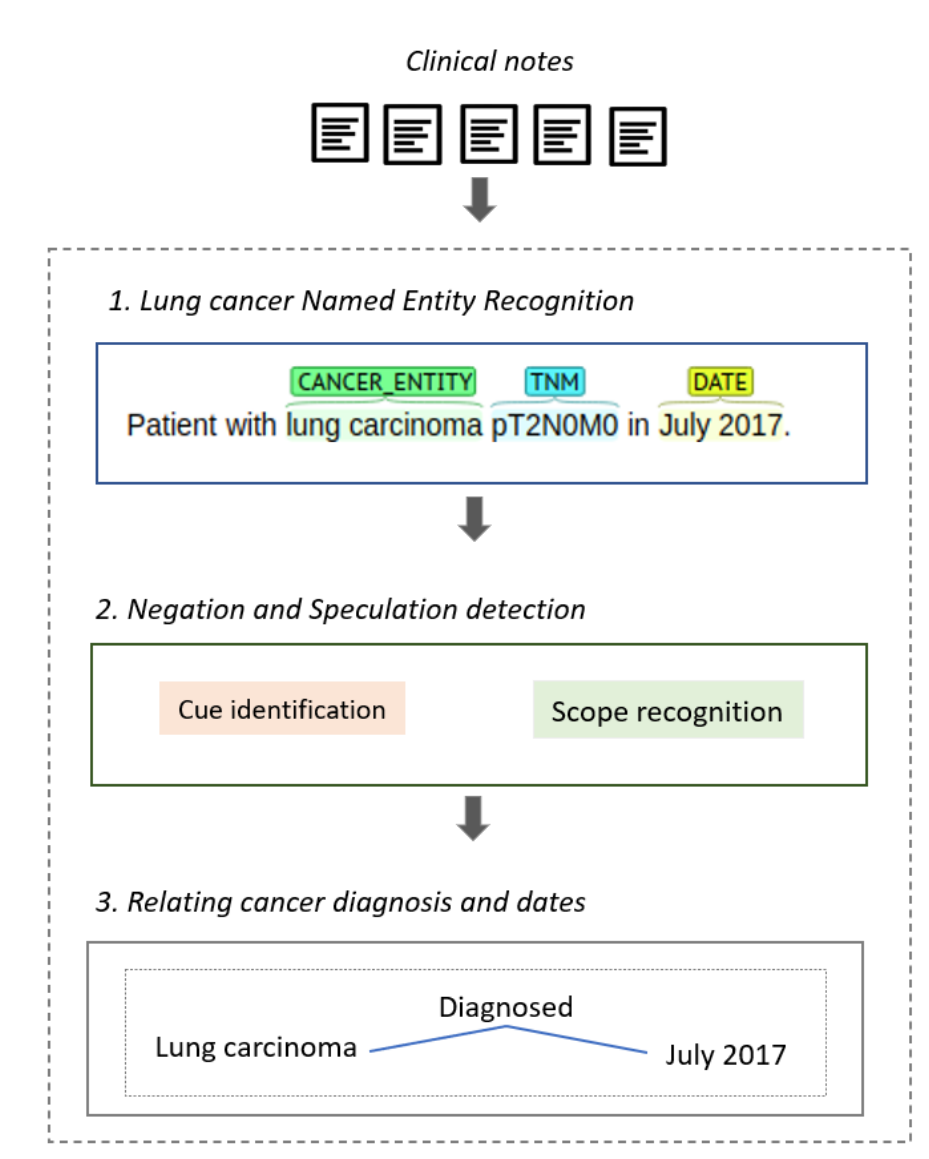
Figure 2. Approach to extract lung cancer